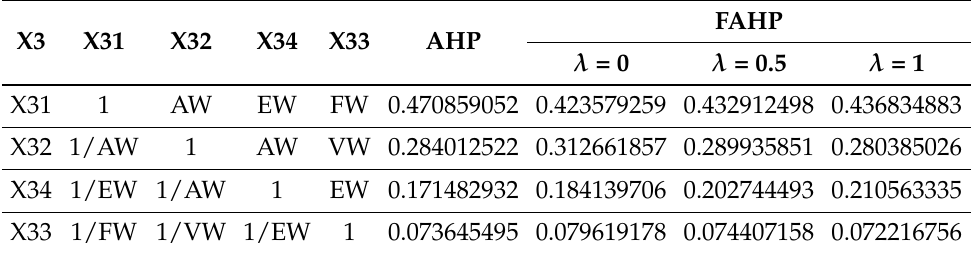
Table 6. Fuzzy comparison matrix for the sub-criteria X3. ( CI = 0.017122, CR = 0.019024).